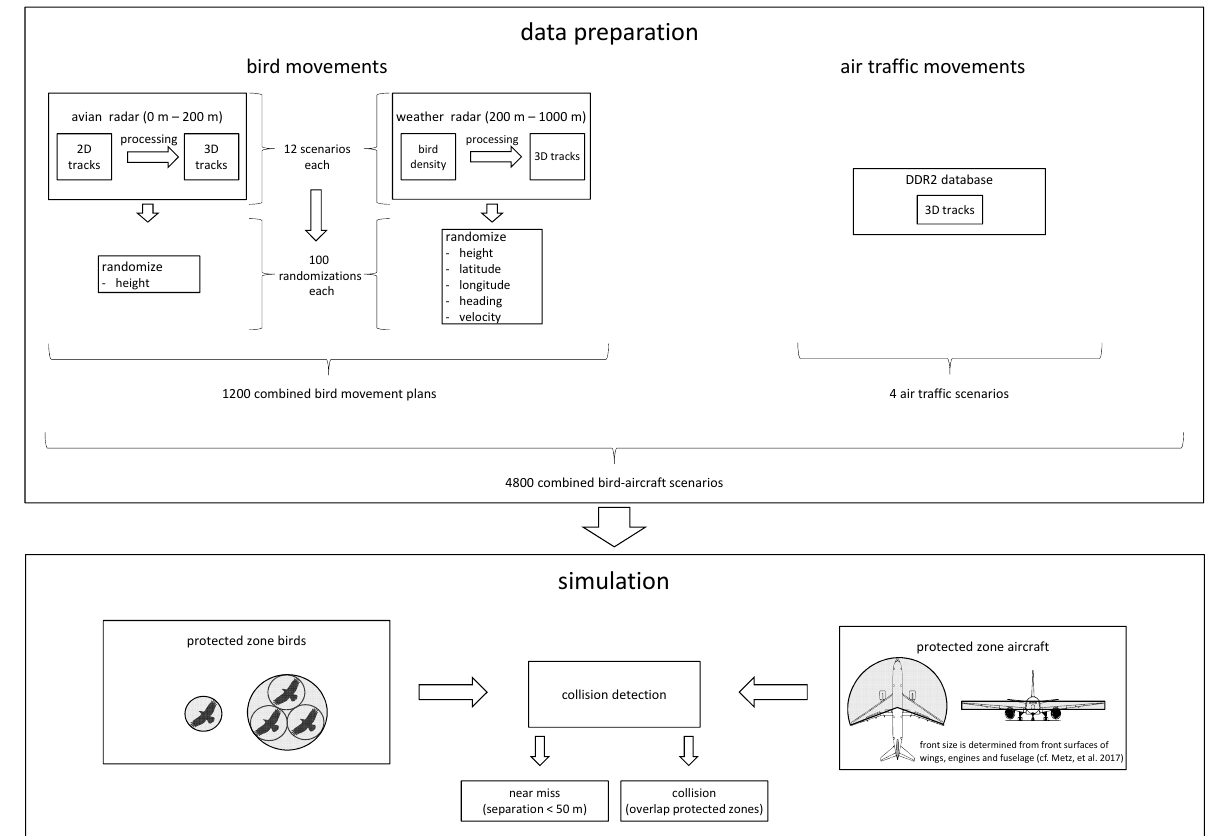
Figure 3. Method overview. Within the data preparation of bird movements, 12 scenarios of bird tracks are generated from weather and avian radar. By randomizing the input parameters 100 times, 1200 bird movement plans result. Air traffic trajectories from four single-runway airports are retrieved from EUROCONTROL’s DDR2 and processed to air traffic scenarios. By combining the bird movement plans with the air traffic scenarios, 4800 bird-aircraft scenarios result. These serve as input for the fast-time simulation. Based on the definition of protected zones (cf. [14]), bird strikes and near misses are counted and